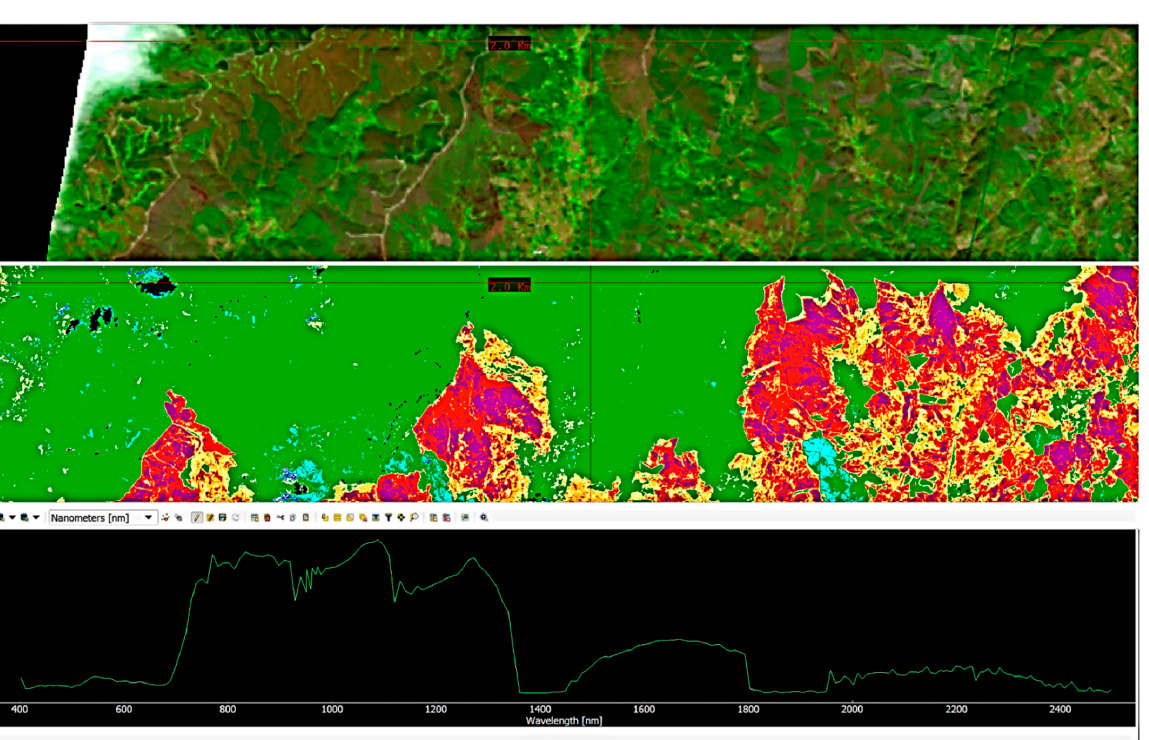
Figure 5 . EnMap toolbox composite view, PRISMA, RBR, and spectral library. Figure 5. EnMap toolbox composite view, PRISMA, RBR, and spectral